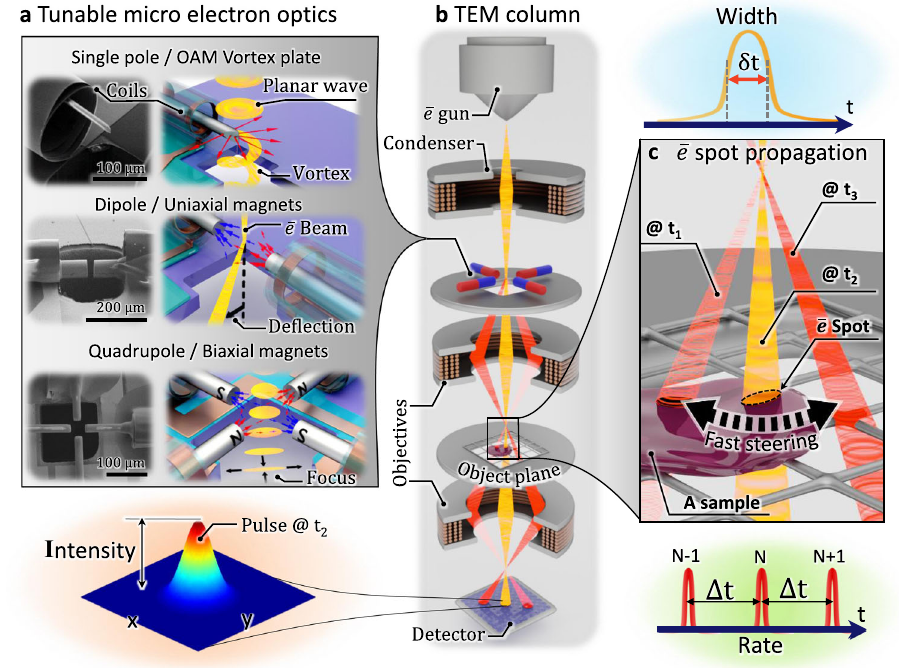
Fig. 1 Tunable microsized magnetic charged particle optics for high energy electron beam systems such as transmission electron microscopes. a Micro-electromagnets designed in three variants: a single pole that can operate as an electron vortex phase plate; a dipole that is built from two collinear micro-coils (two uniaxial magnets); a quadrupole assembly (four biaxial magnets) that can be con fi gured to either generate a strong fl ux gradient needed to perform focusing functions or to generate an in-plane vector fi eld whose orientation can be changed dynamically. b Simpli fi ed sketch of a TEM column demonstrating the principle of electron beam modulation with microscale electromagnets inserted in an aperture plane of the microscope. c Micro electro magnets provide a unique possibility to steer the beam with high rate providing means for high speed stroboscopy with a narrow and intense electron beam pulse probing the